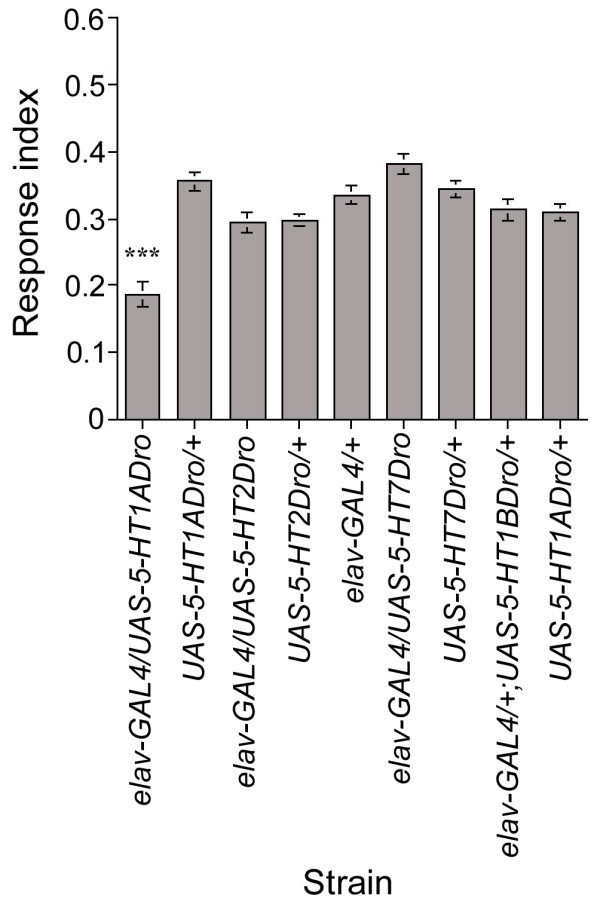
Pan-neural expression of 5-HT1ADro receptors reduces the larval response to light. Pan-neural expression of 5-HT1ADro, 5-HT1BDro, 5-HT2Dro, or 5-HT7Dro receptors in all post-mitotic neurons was carried out by using the elav-GAL4 driver. Early foraging 3rd instar larvae expressing 5-HT1ADro receptors but not any of the other 5-HT receptor subtypes in the nervous system showed significantly reduced response to light when compared with both parental control larvae (elav-GAL4/UAS-5HT1ADro, n = 27, RI = 0.19; elav-GAL4/+, n = 20, RI = 0.33; UAS-5HT1ADro/+, n = 30, RI = 0.36; ANOVA: F(2,74) = 34.61, p < 0.001). *** p < 0.001.